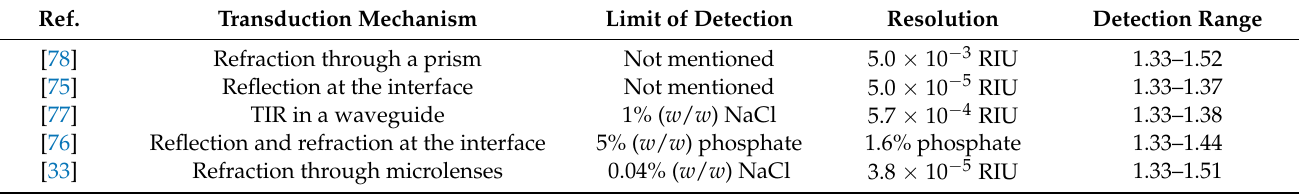
Table 3. Comparison of the intensity-modulation-based optofluidic RI sensor in terms of configuration and